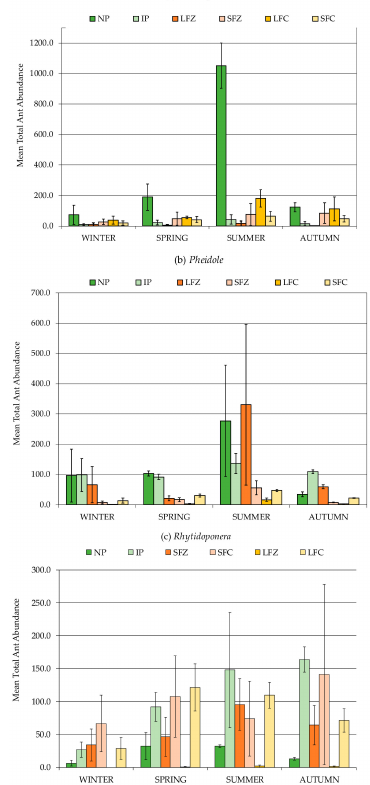
Figure 6. Mean abundance (mean total per field) of three dominant ant genera from most to least abundant: ( a ) Iridomyrmex, ( b ) Pheidole, ( c ) Rhytidoponera, and under six agricultural management regimes during the study period. Each data point was the total abundance of 20 pitfall traps per field, with each field (n = 24) sampled on eight occasions, once in each season and repeated in the following calendar year. The mean for a specific agricultural management regime was based on the number of replicates for that particular grouping i.e., a specific agricultural management regime such as native pasture monitored in winter (n = 8). Total number of sampling occasions = 192. Bars signify ± SEM. NP = native pasture, IP = introduced pasture, LFZ = long fallow zero tillage, SFZ = short fallow zero tillage, LFC = long fallow conventional tillage, SFC = short fallow conventional